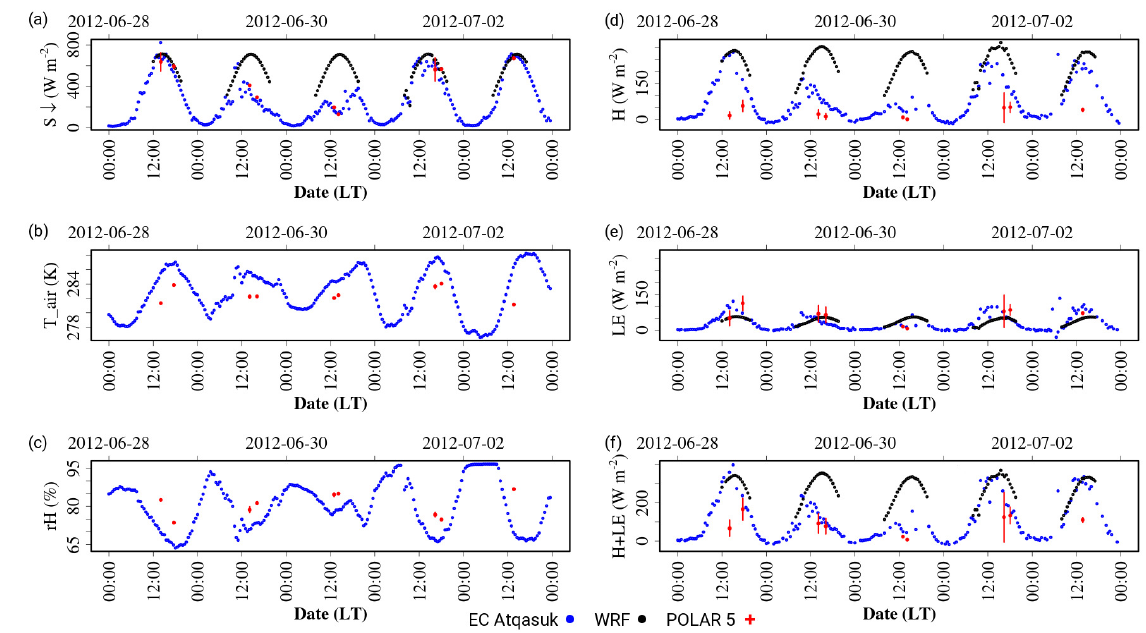
Figure 11. Left frame: shortwave radiation (a) , air temperature (b) , and relative humidity (c) . Right frame: sensible heat flux (d) , latent heat flux (e) , and sum of the sensible heat and latent heat fluxes (f) based on measurements from the EC tower at Atqasuk (blue), the Polar 5 airborne survey (red), or output from the WRF model (black). Red error bars indicate mean absolute deviations of the averaged Polar 5